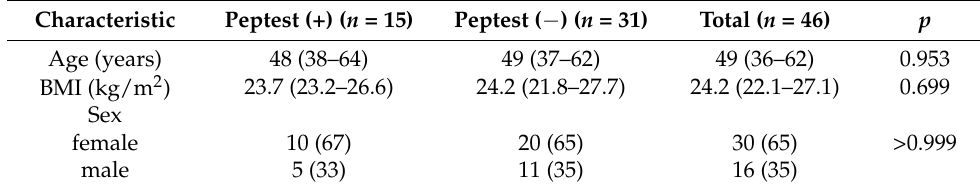
Table 1. Characteristics of the study